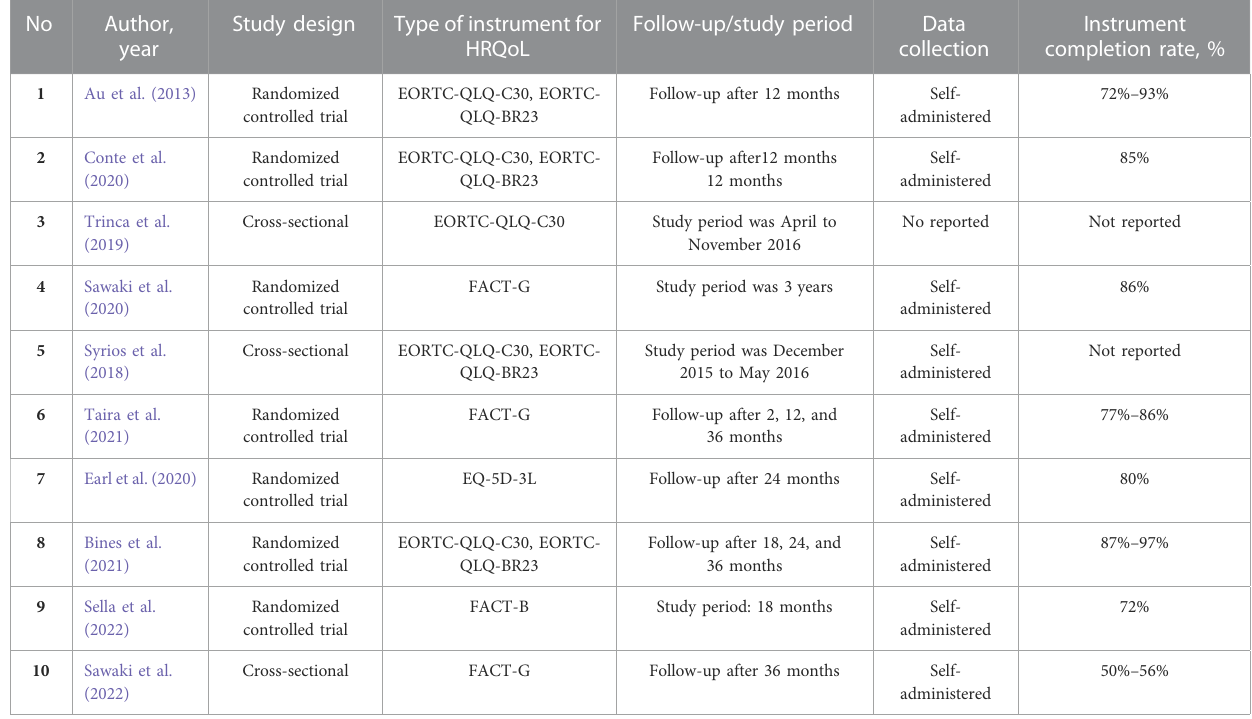
TABLE 1 Characteristics of the included